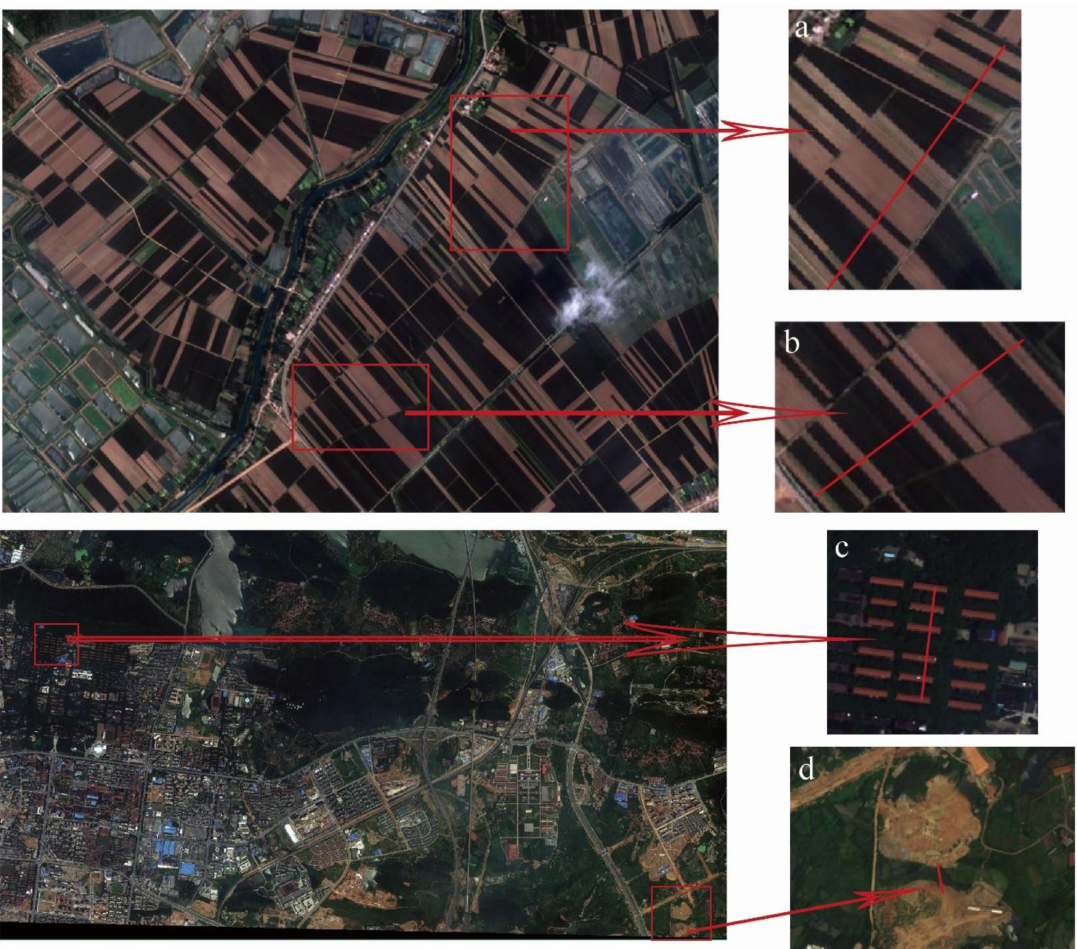
Figure 3. High-contrast scenarios in GF-2 and Worldview-2 images. And ( a – d ) are four example parts of the GF-2 image and the Worldview-2 image.